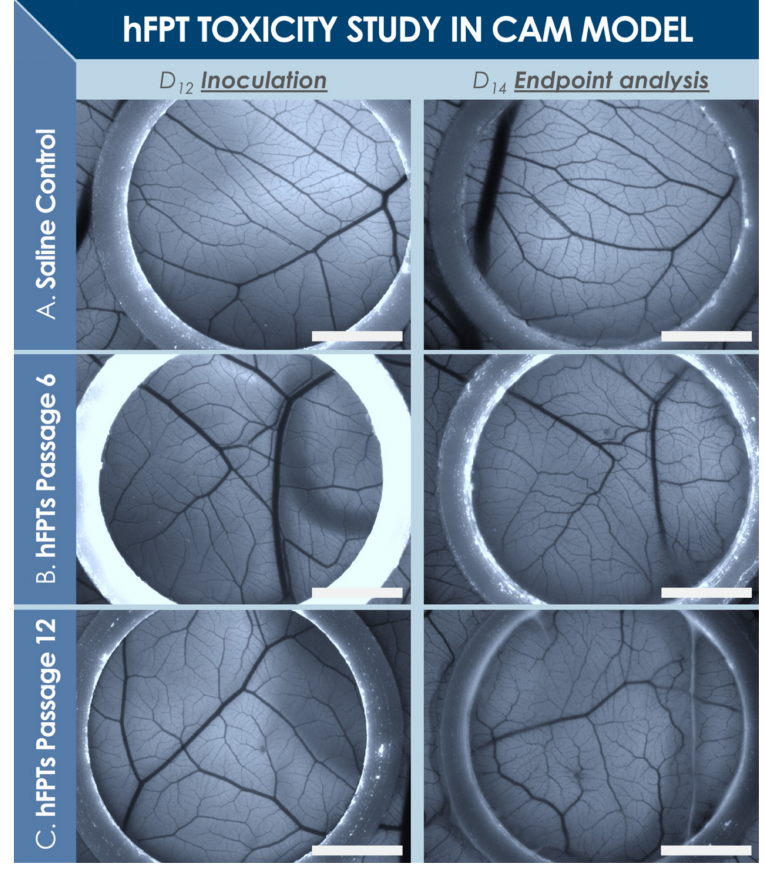
Figure 4. Representative data of standardized CAM assay for evaluation of hFPT toxicity in